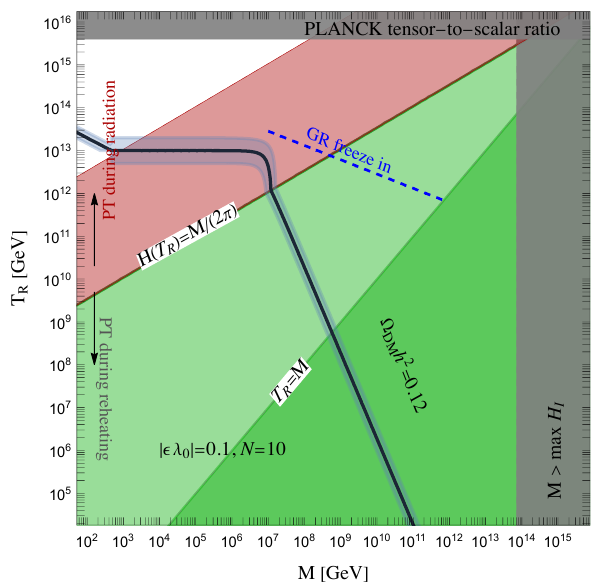
Figure 4 . Parameter space of Dilaton DM. The DM abundance is reproduced along the black solid line. The darker green region corresponds to T Λ where the gravitational freeze-in (blue line) R ≤ becomes inefficient (see eq. (2.1)). The lighter green region corresponds to H Λ where the phase R ≤ transition happens during reheating. The red region is highlighted to show where the contribution from phase transition generated in radiation domination dominate over the gravitational